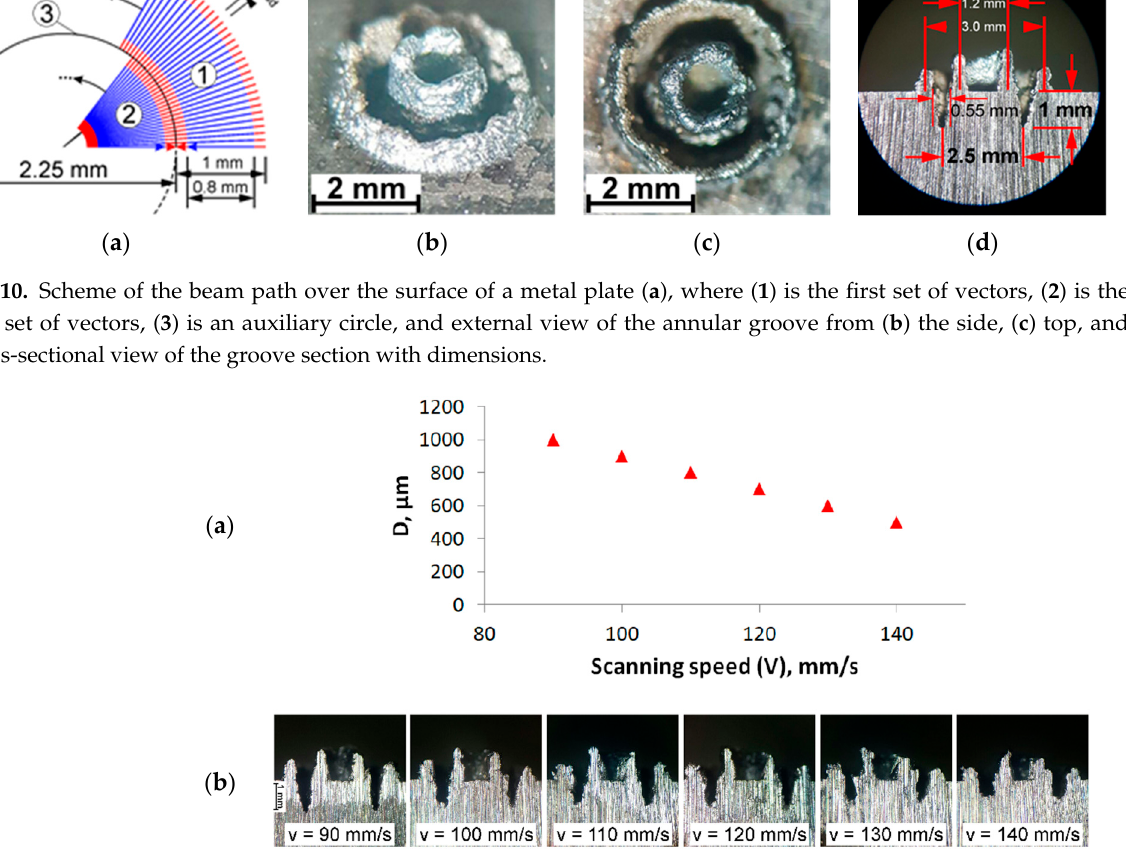
Figure 10. Scheme of the beam path over the surface of a metal plate ( a ), where ( 1 ) is the first set of vectors, ( 2 ) is the second set of vectors, ( 3 ) is an auxiliary circle, and external view of the annular groove from ( b ) the side, ( c ) top, and ( d ) cross- sectional view of the groove section with dimensions.